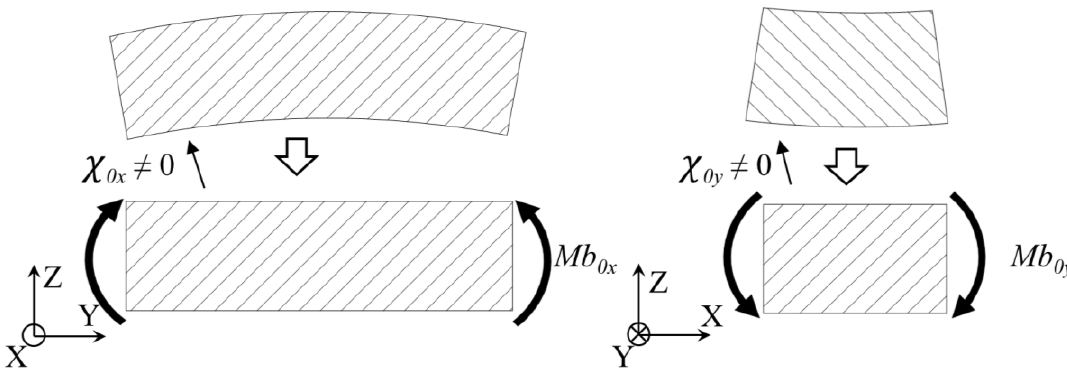
Figure 2. Initial deformation of the machining blank in the unclamped position and bending moment applied by the clamping.